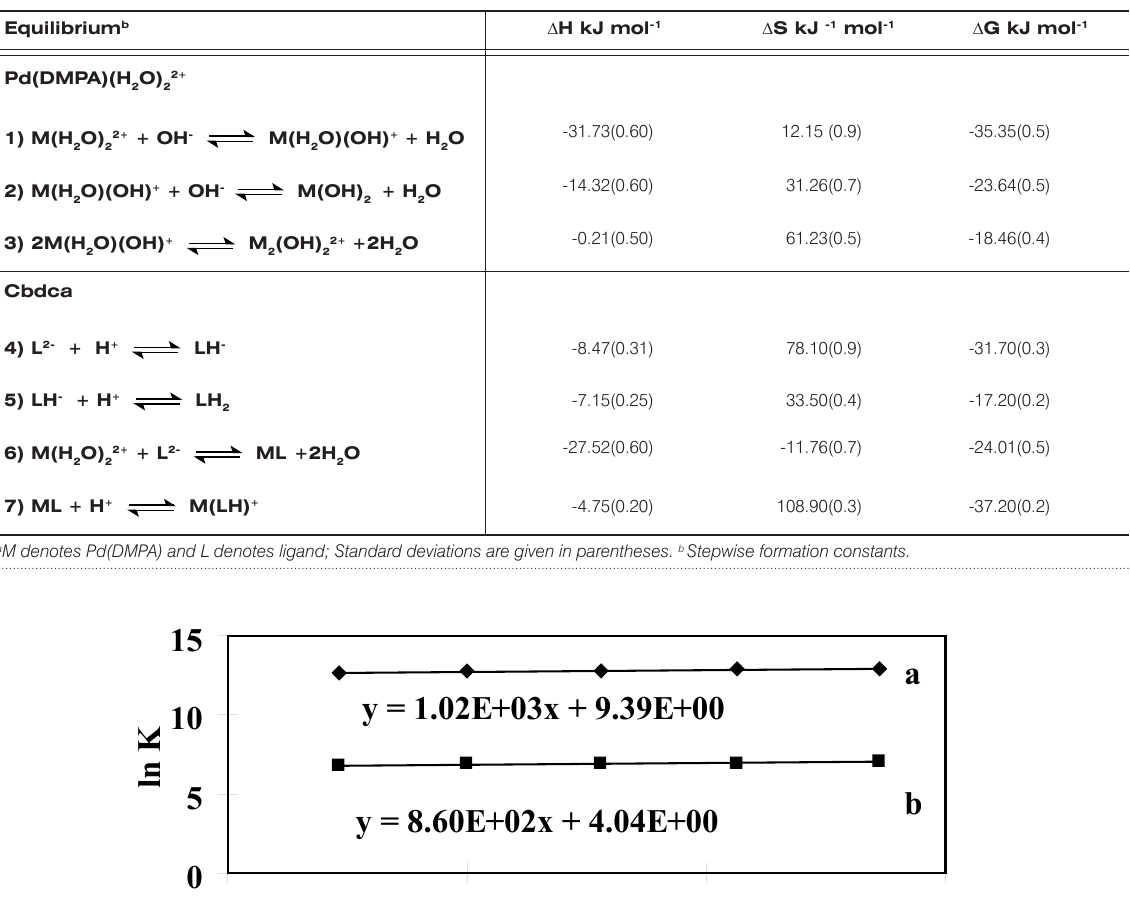
Table 5. Thermodynamic parameters for the equilibria of Pd(DMPA) complexes. a